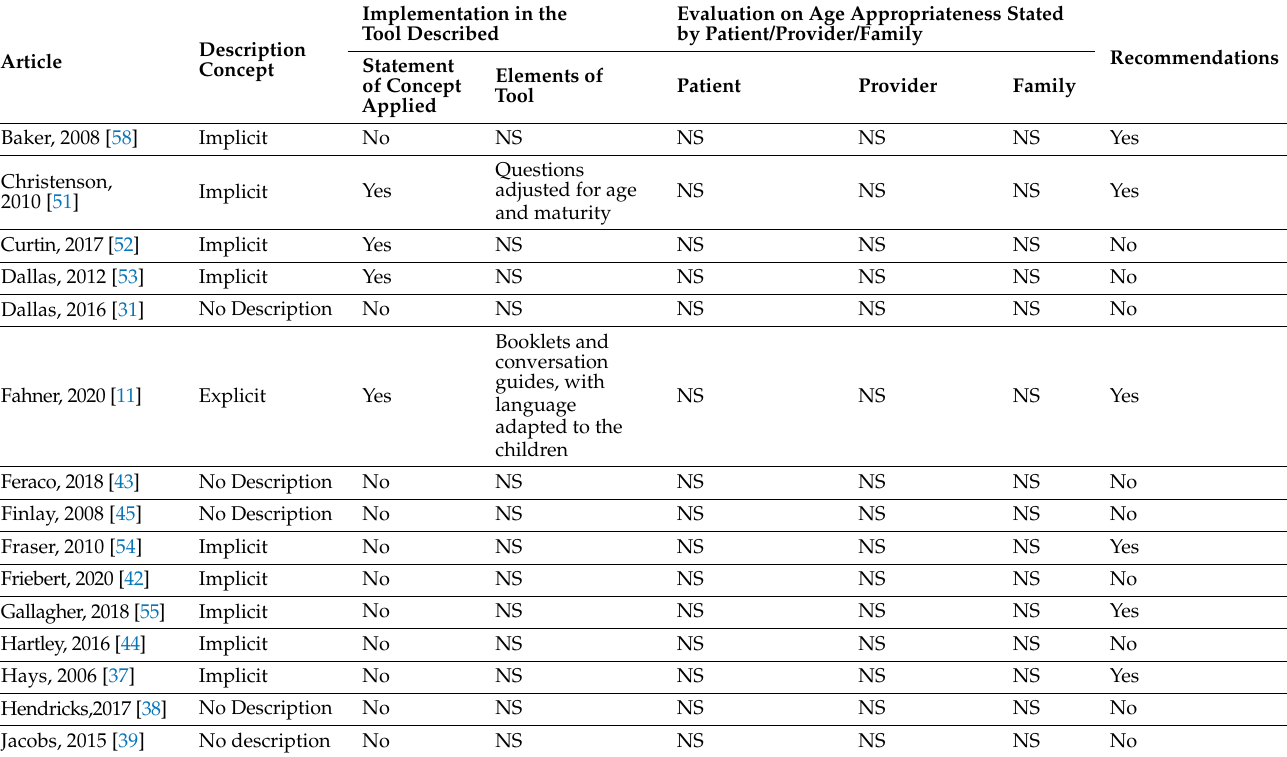
Table 8. Age-appropriate